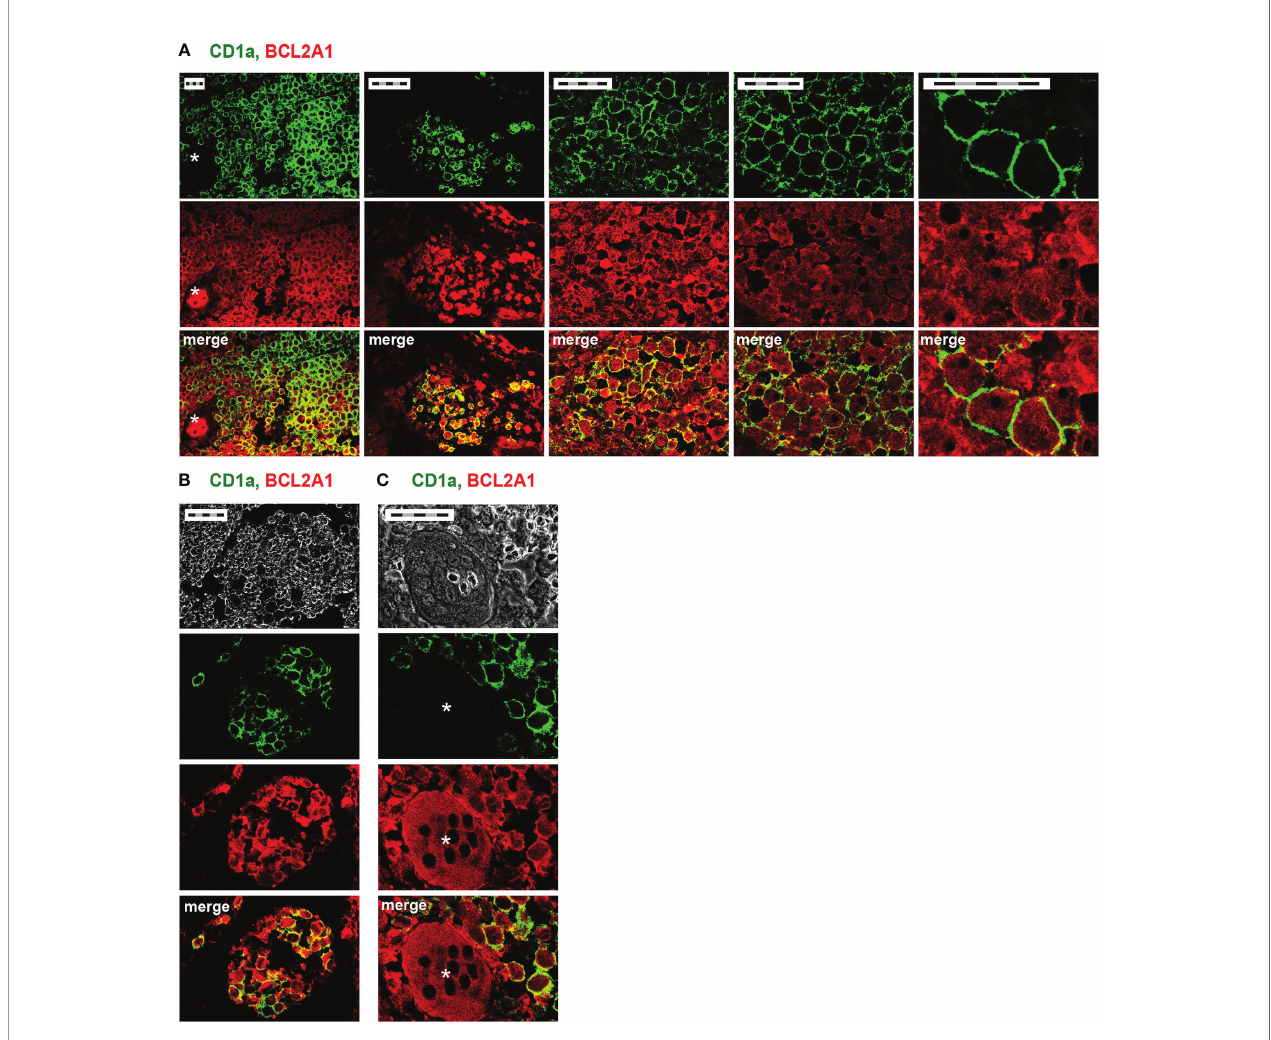
FIGURE 1 | CD1a and BCL2A1 expression in LCH lesions after immunohisto fl uorescence staining. Representative confocal microscopy images of immuno fl uorescence staining on bone lesions from two patients with LCH ( A, p12 and B, C, p11). Staining of CD1a (green, DC marker), BCL2A1 (red), and their co- localization (yellow) are shown. (A) Pathogenic LCH-DCs co-express CD1a and BCL2A1. Different magni fi cations of the same lesion focusing on mononucleated cells. (B) Improved delineation of LCH granulomas using BCL2A1 compared to CD1a. (C) Multinucleated giant cells (MGCs) expressing BCL2A1 in bone granuloma. *indicates MGCs. Scale bars: 50 µm (5 x 10